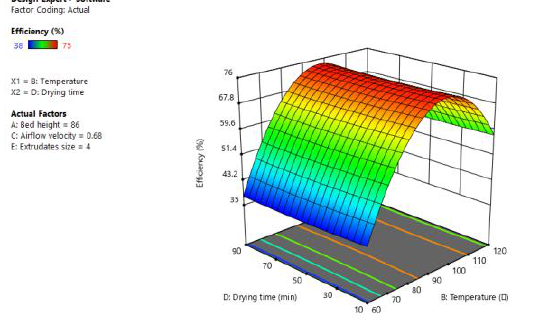
Figure 5: A perturbation plan for fluidizied bed efficiency